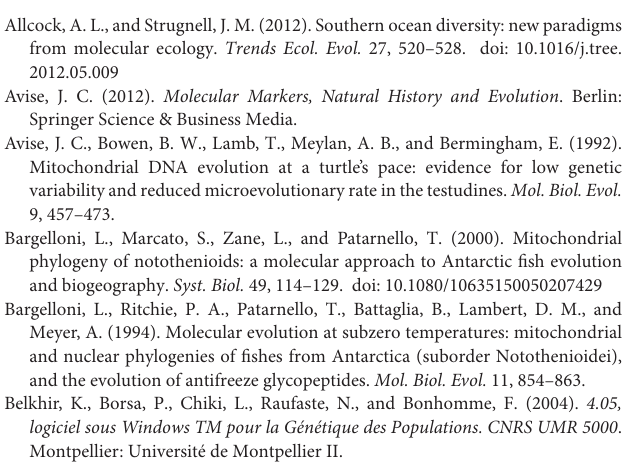
Supplementary Figure 3 | Genetic clusters after Delta K Evanno’s correction in results of STRUCTURE analyses. (A) All 15 populations combined: K = 3, mean (| Ln”(K)|) = 421.18, Stdev Ln P(K) = 18.70, Delta K = 22.52; (B) Subareas 58: K = 2, mean (| Ln”(K)|) = 31.37, Stdev Ln P(K) = 3.36, Delta K = 9.33; (C) Subareas 88: Supplementary Figure 4 | Population structure based on a Bayesian population assignment separately for the Subareas 58 and 88 of Dissostichus mawsoni in the Antarctic Ocean using seven microsatellite loci. Each individual is represented along the X -axis, and the Y -axis denotes the probability of that individual belonging to each of the genetic clusters. (A) Analyses of population structure only for five populations from the Subareas 58. The most likely number of genetic clusters after Delta K Evanno’s correction corresponds to K = 2 ( Supplementary Figure 3B ). (B) Analyses of population structure for ten populations from the Subareas 88. The most likely number of genetic clusters after Delta K Evanno’s correction corresponds to K = 3 ( Supplementary Figure 3C ). Supplementary Figure 5 | Results of factorial correspondence analysis (FCA) showing multivariate relationships for each of the Subareas 58 and 88 of Dissostichus mawsoni based on seven microsatellite allelic variation. (A) Analyses of FCA for five populations from the Subareas 58. (B) Analyses of FCA for ten populations from the Subareas 88. Different colors of each circle represent different populations.